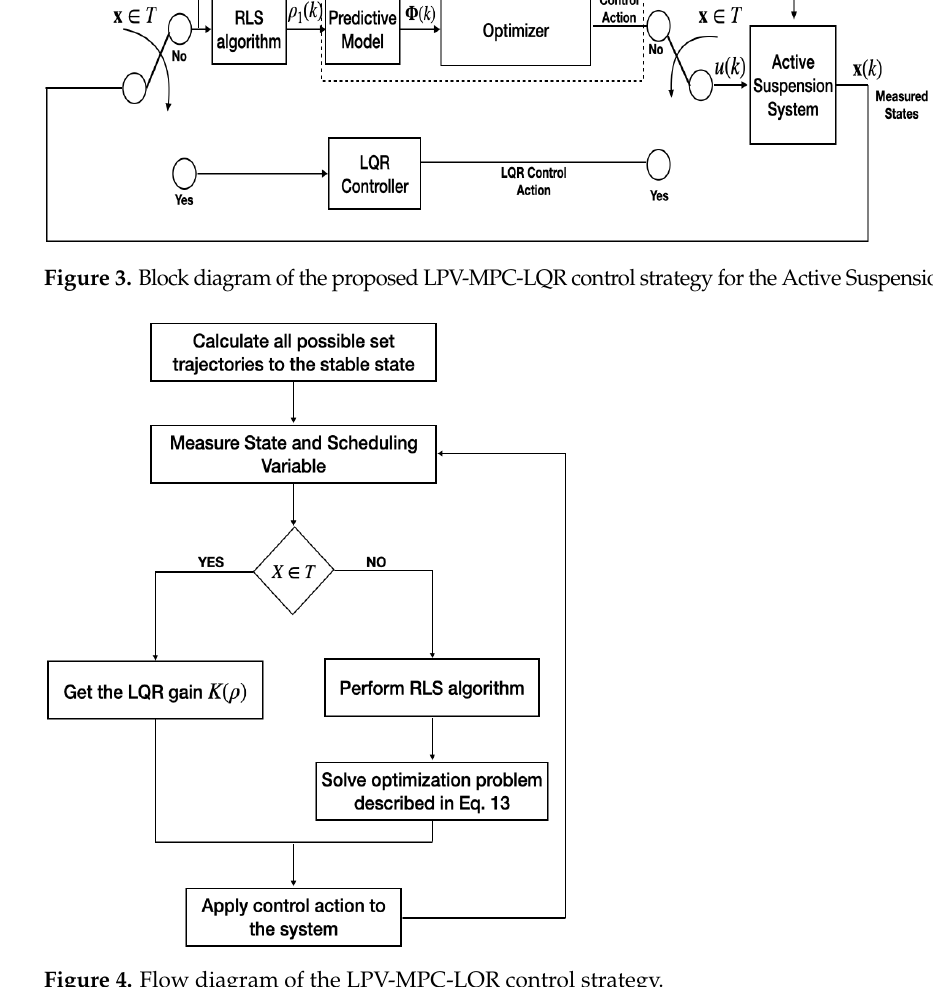
Figure 4. Flow diagram of the LPV-MPC-LQR control